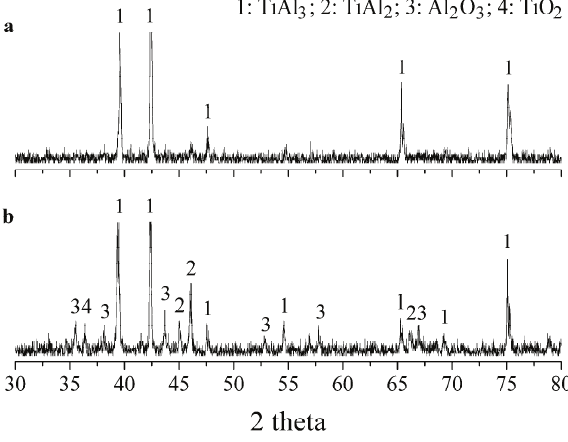
Figure 5. Surface X-ray diffraction patterns of the coat- ing/TA15 after interrupted oxidation for 300 h in air. a – 973 K; b – 1073